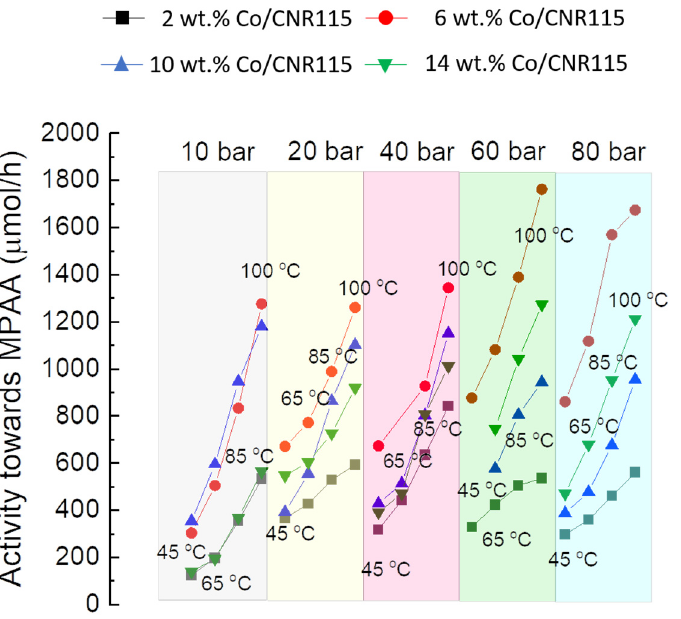
Figure 7. Activity towards 2-methylpentanal in hydrogenation of 2-methyl-2pentenal at different values of pressure and temperature for 2, 6, 10 and 14 wt.% Co/CNR115.